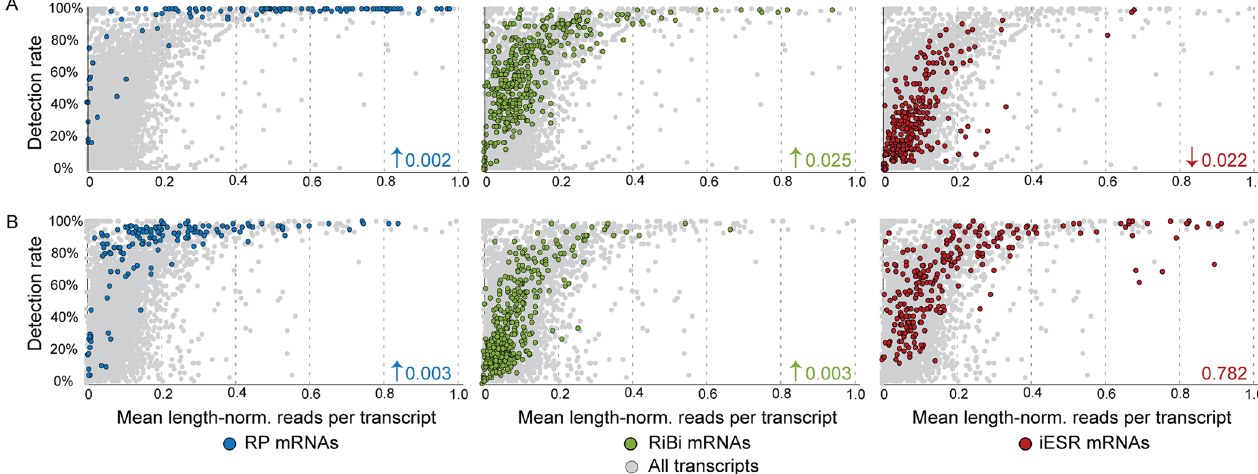
Fig 3. Transcript detection rate correlates with functional class. The fraction of cells in which each mRNA was detected was plotted against the mean length-normalized read count for that transcript, calculatedfrom cells in which the transcript was measured, in (A) unstressedor (B) stressed cells. Listed p -values and arrows (where significant)indicate if the detectionrate was higheror lower than randomly sampledgenes. Plots are zoomed in to show transcripts whose mean read count is below1.0; most transcripts abovethis range are detected in all cells, not shown. iESR, induced-EnvironmentalStress Response;RiBi, ribosomebiogenesis;RP, ribosomal protein.